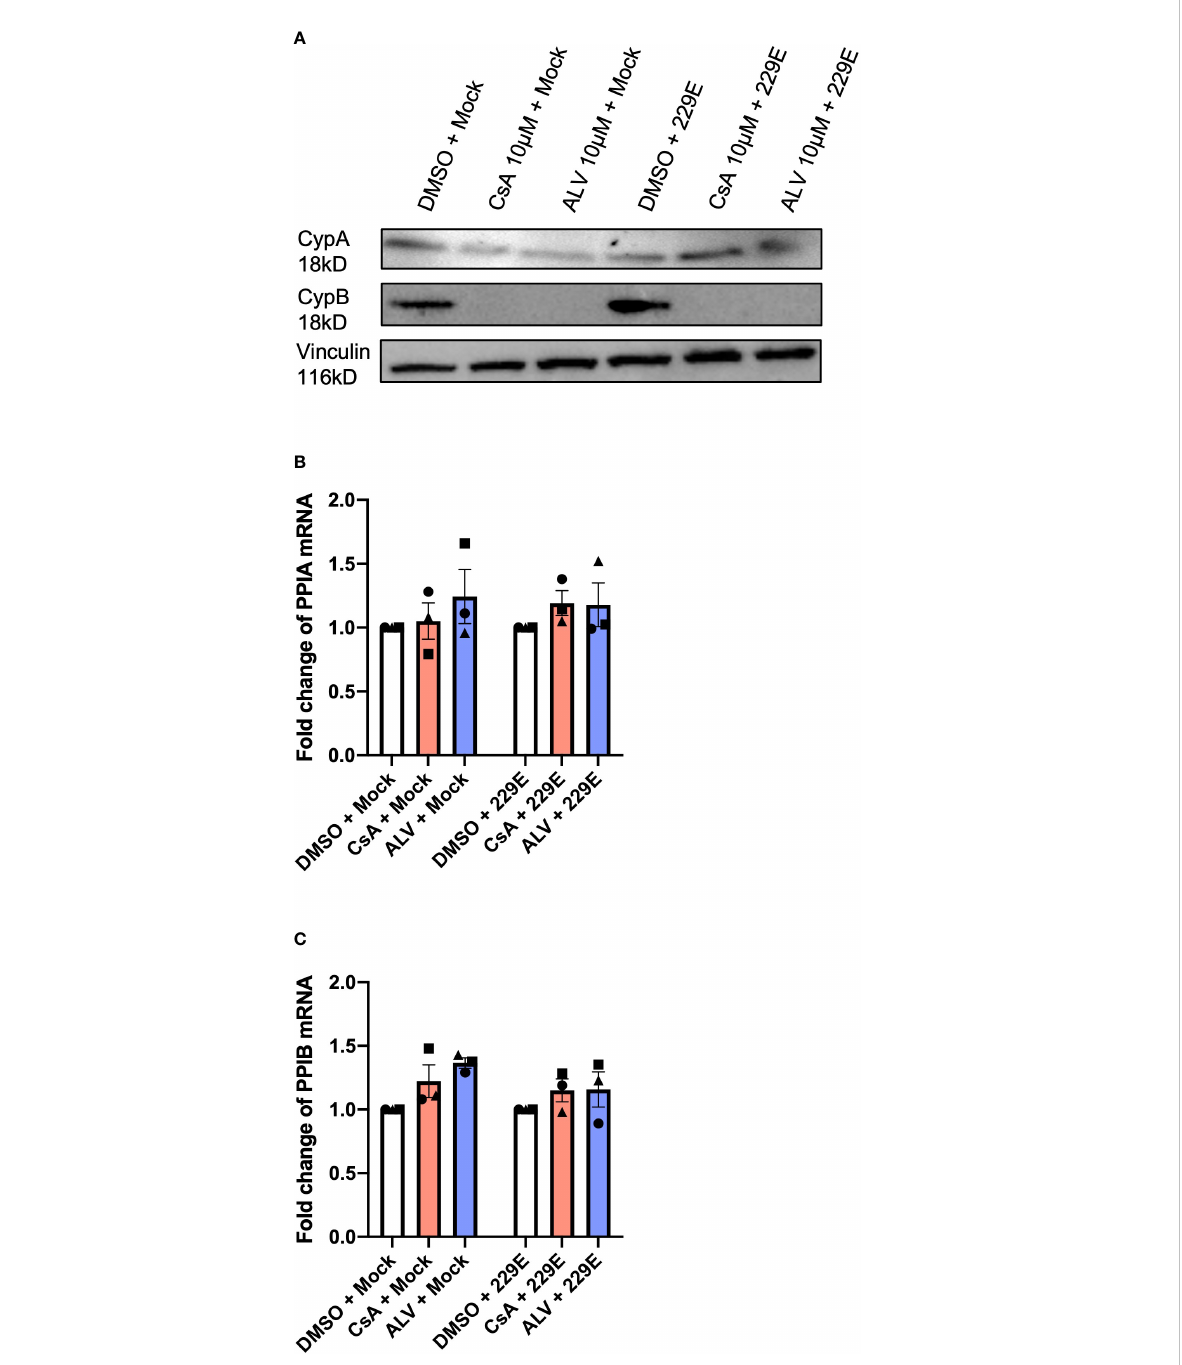
FIGURE 2 CsA and ALV strongly downregulate CypB but not CypA protein levels in phBECs. (A) Immunoblot analysis of total cell lysate after CsA and ALV treatment reveals strong downregulation of CypB protein levels as opposed to comparably little effect on CypA, both in presence and absence of infection. Blot is representative of n = 3 independent experiments (B) RT-qPCR of PPIA expression depicted as fold changes normalized to the housekeeping gene DEAH-Box Helicase 8 ( DHX8 ). The symbols each represent an independent donor (circles = donor 1; squares = donor 2; triangles = donor 3). (C) RT-qPCR of PPIB expression depicted as fold changes normalized to the housekeeping gene DEAH-Box Helicase 8 ( DHX8 ). The symbols each represent an independent donor (circles = donor 1; squares = donor 2; triangles = donor 3). The drug and infection treatment of phBECs were the same in the RT-qPCR as well as the immunoblot analysis (48 h pretreatment, followed by 72 h HCoV-229E